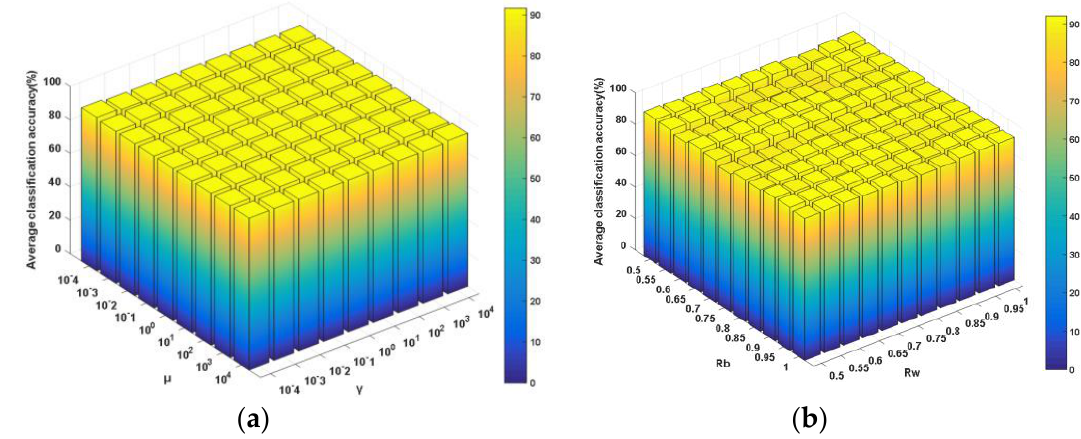
Figure 12. SVM plus NDCA performance under different combinations of parameters. ( a ) μ and γ ( best : 91.7009%; worst : 90.8676%); ( b ) Rb and Rw ( best : 91.9787%; worst : 87.2679%).